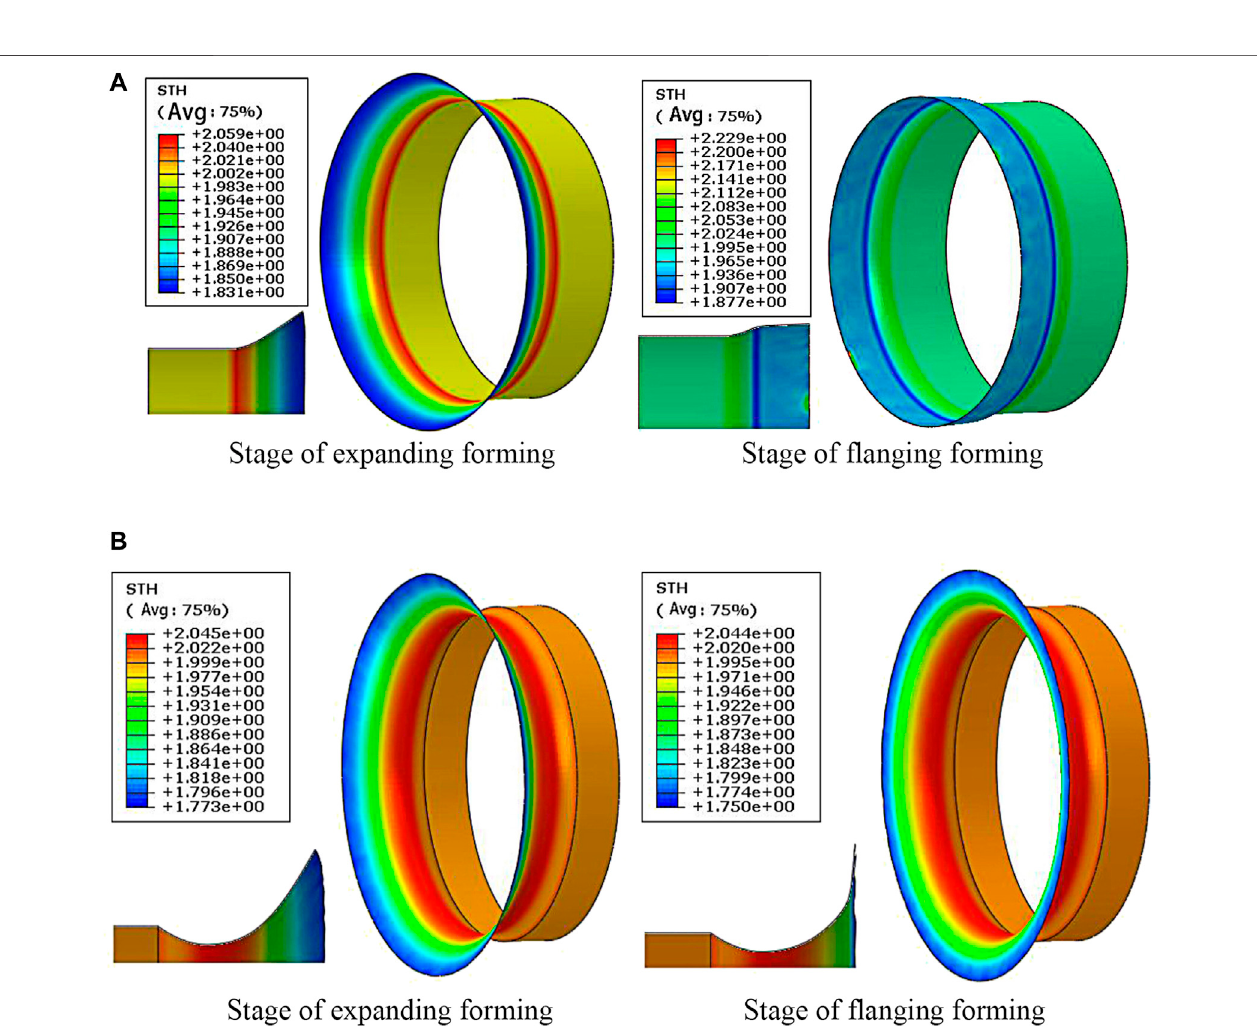
Frontiers in Energy Research |